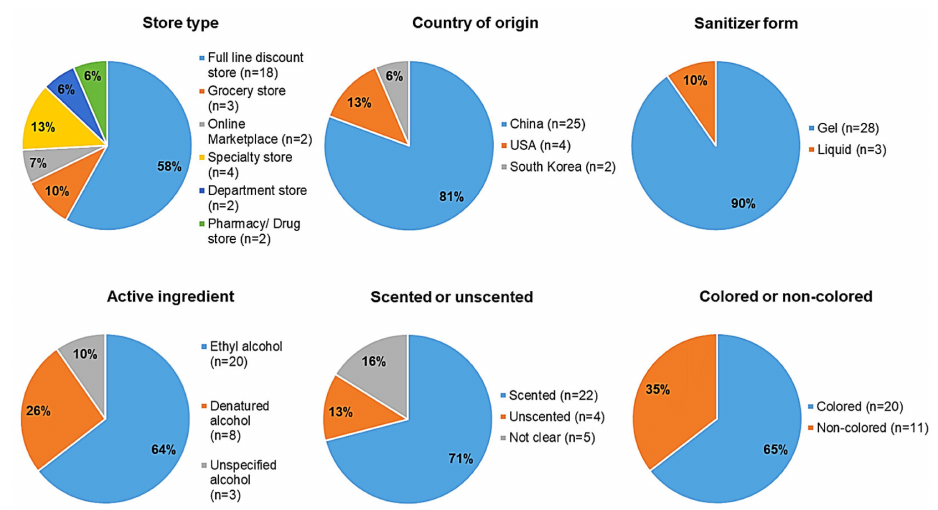
Figure 2. Key attributes of Hand Sanitizers Marketed to Children Selected for